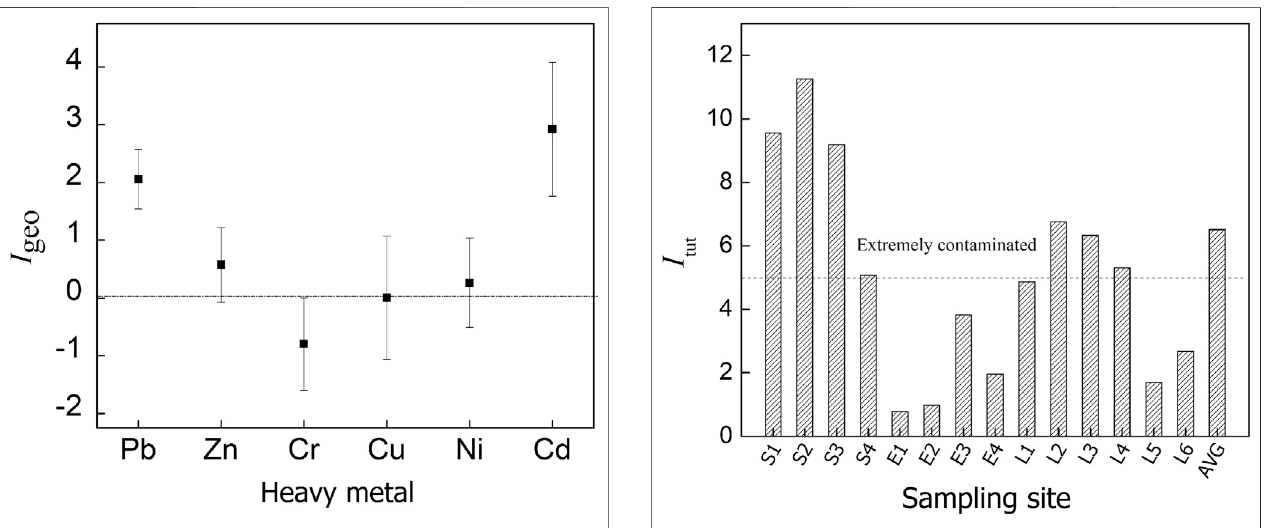
FIGURE 3 | I tut of the heavy metals in super fi cial